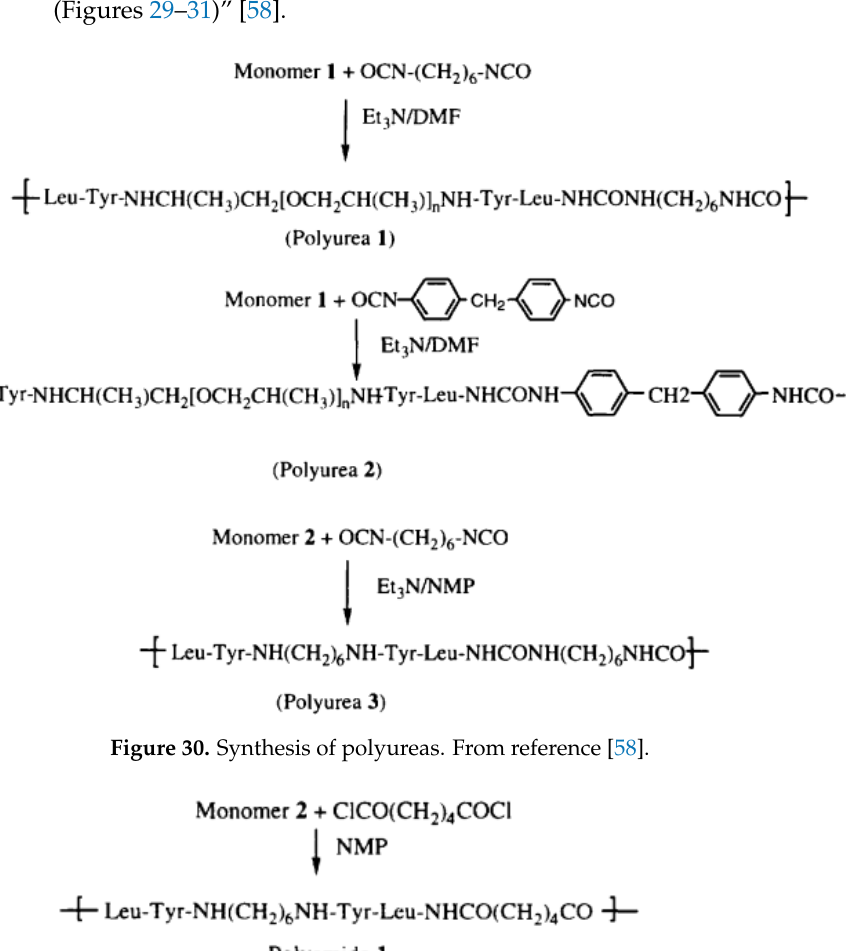
Figure 32. Overall scheme of NIR route of polyurea (the solid-line portions are carried out successfully in the study). From reference [17]. Microwave irradiation could be an alternative method used to synthesize polyureas; however, the necessity of solvents with high boiling points, such as dimethylacetamide or dichlorobenzene, becomes an additional health and environmental barrier [59]. However, in a non-isocyanate route (NIR) to polyurea, the approach based on MDI-biscarbamates seems promising because no high-temperature condition is required through trans-esterification or trans-ureation. In an initial NIR process development, the trans-ureation of 4,4 ′ -DM-MDC and 4,4 ′ -DP-MDC was carried out by mixing the same equivalent of polyetherdiamines, such as 1,8-diamino-3,6-dioxaoctane (DADO), at 160 °C in the absence of a solvent and catalyst [17]. During the melt-polymerization, methanol or phenol was flushed out from the reaction mixture by continuous purging with a nitrogen stream under reduced pressure. Powdered Polyurea [4,4 ′ -DM-MDC/DADO]melt/ 160, (P-1), were isolated after 60 min of reaction, and GPC analyses suggested that P-1 had M.W. of 6000~7000 kDa. These M.W.s indicated a low degree of polymerization that